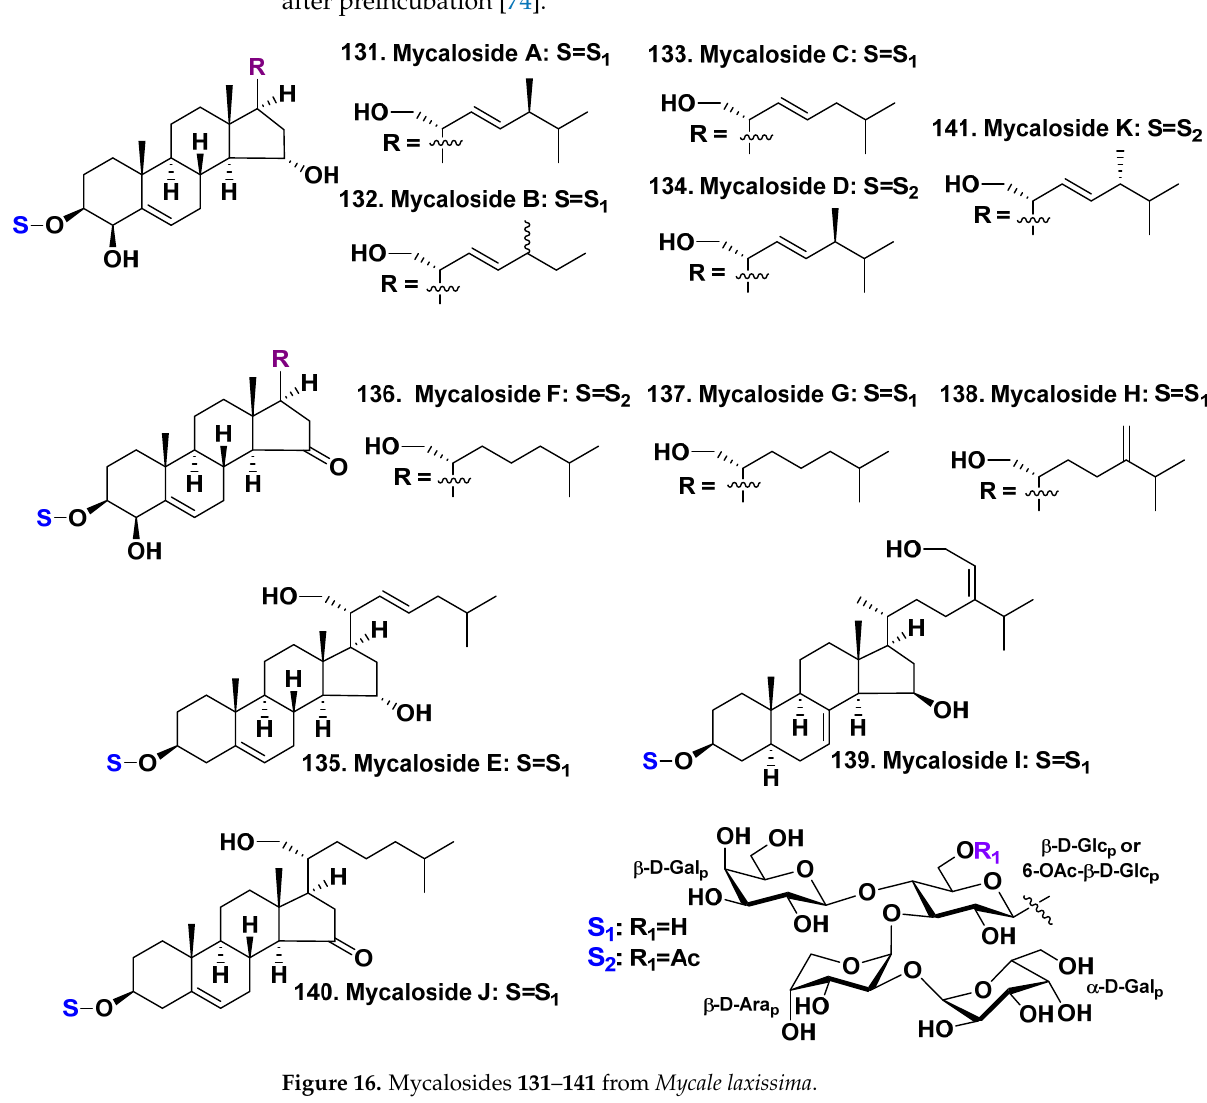
Figure 16. Mycalosides 131 – 141 from Mycale laxissima .